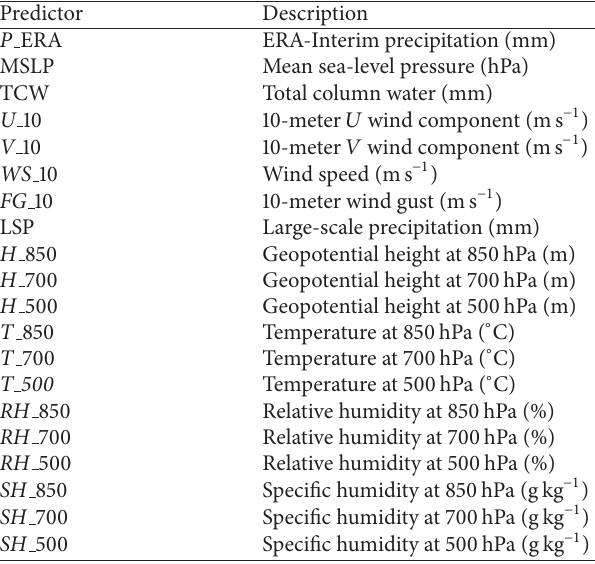
Table 1: Predictors from ERA-Interim forecast dataset. All variables are aggregated from 3-hourly to daily